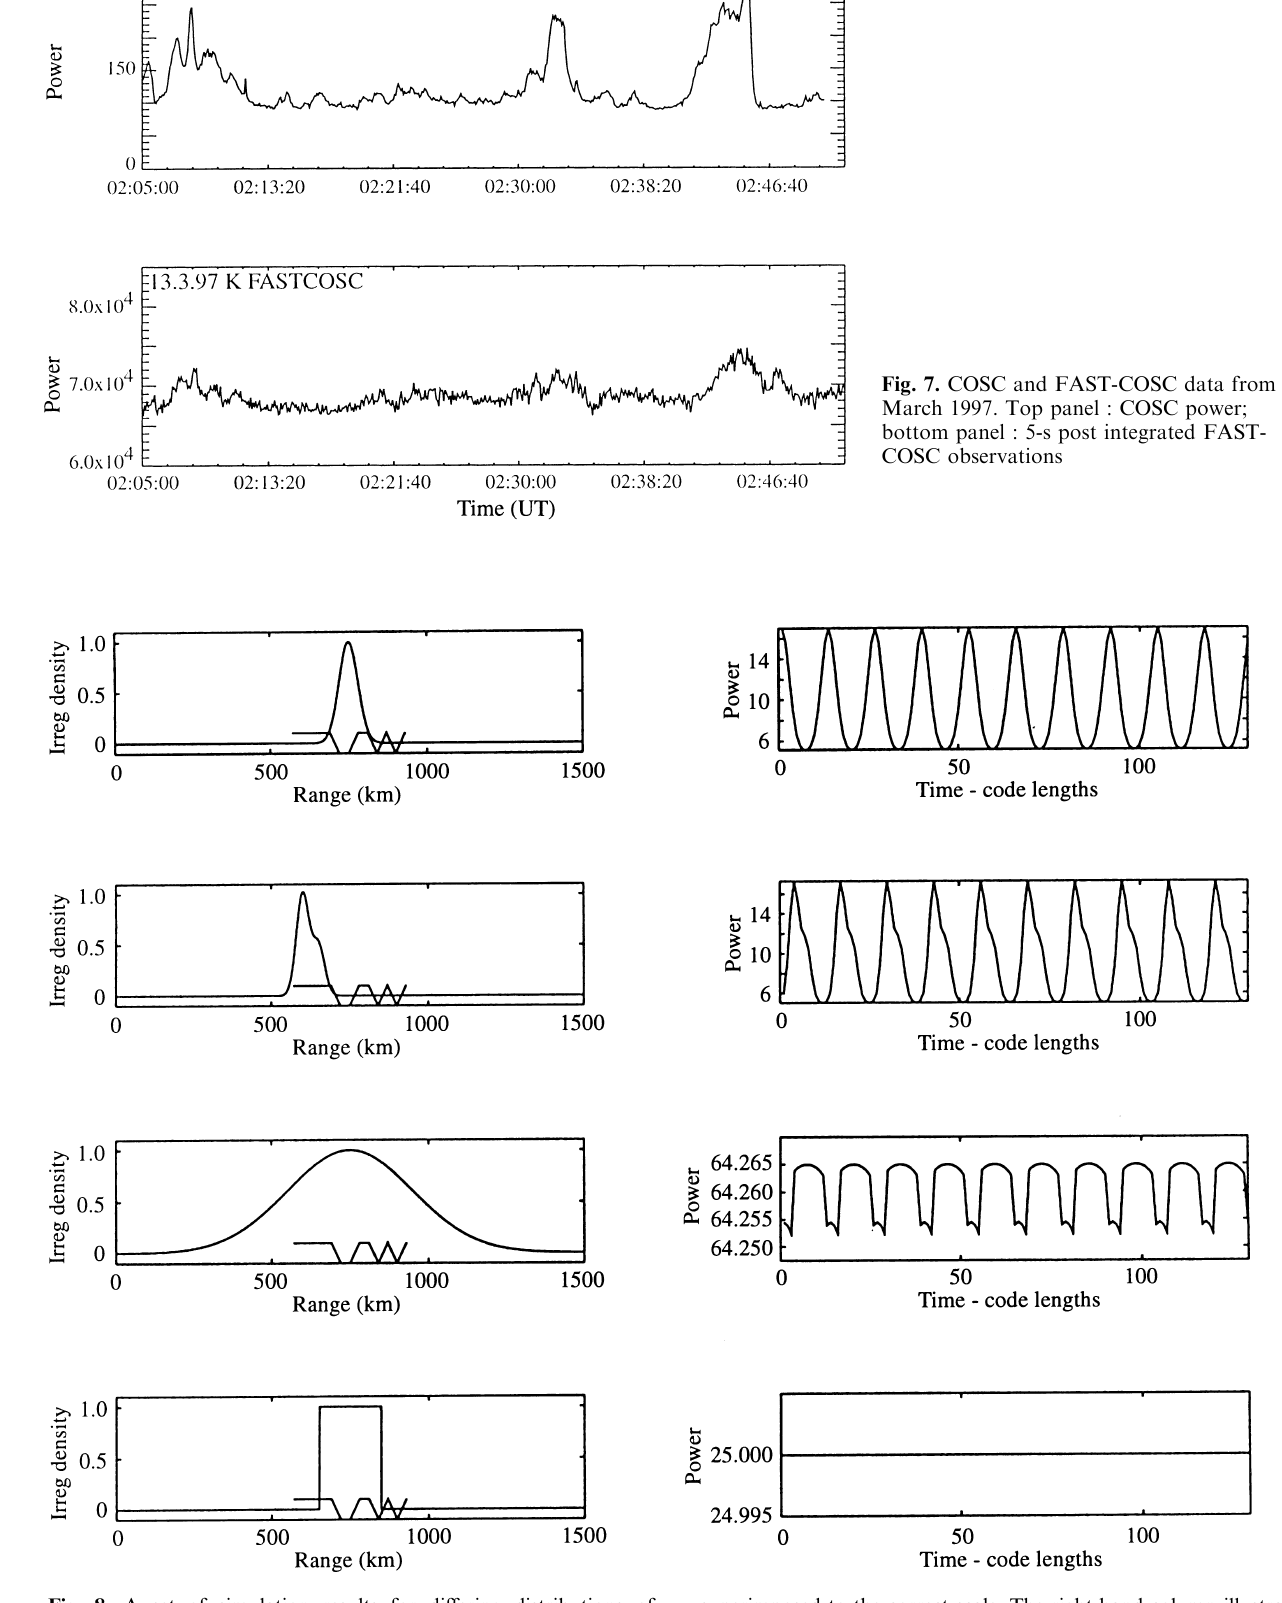
Fig. 8. A set of simulation results for di(cid:128)ering distributions of irregularities with range. The left-hand column depicts a modelled range distribution of irregularities with a full Barker code sequence